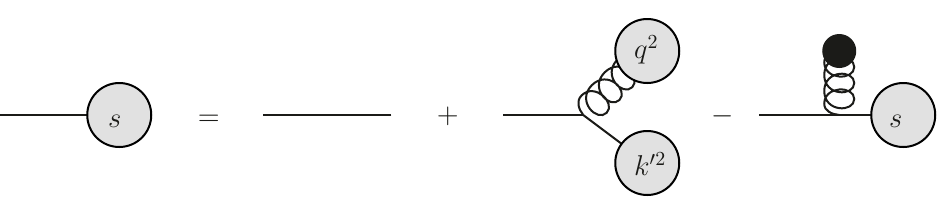
Figure 2. Graphical representation of the evolution equation eq. (3.10): grey blobs denote the quark and gluon jet function at a given jet mass, a single line implies a (cid:14) -function at mass zero, while the black dot represents a factor of one and implies an unconstrained integration over the gluon’s emission scale and momentum